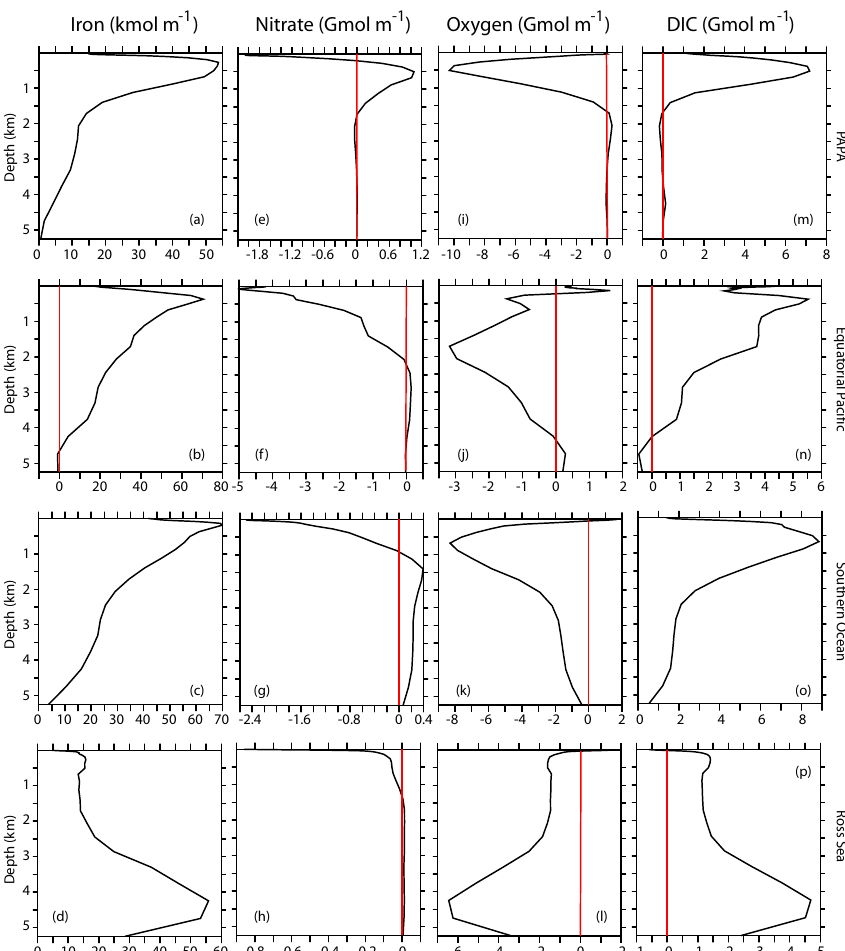
Fig. 6. Global horizontally integrated 100-year cumulative perturbation results of the 1200x iron fertilization scenarios plotted as a function of depth. The first column, (a to d) , is the iron concentration perturbation in kmolm − 1 ; the second column, (e to h) , is the nitrate concentration perturbation in Gmolm − 1 ; and the third column, (i to l) , is the oxygen concentration perturbation in Gmolm − 1 . The first row of results is for PAPA, the second for the equatorial Pacific, the third for the Southern Ocean and the bottom row is the Ross